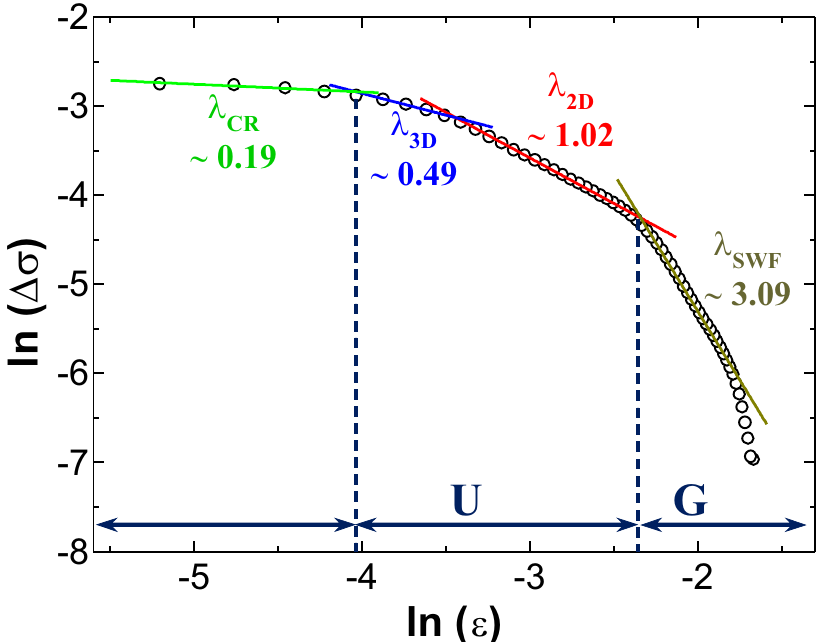
Figure 9. Fluctuation-induced conductivity (FIC) analysis plotting ln ( ∆ σ ) vs. ln ( (cid:101) ) . Three main regimes can be identified (see main text), CR ( ), MFR and SWF ( ). The MFR regime comprises the 2D- ( ) and 3D- ( ) regimes. The dashed lines show the crossover temperatures, T LD and T 2D − SWF . The plot further indicates the conductivity exponents, see also Table